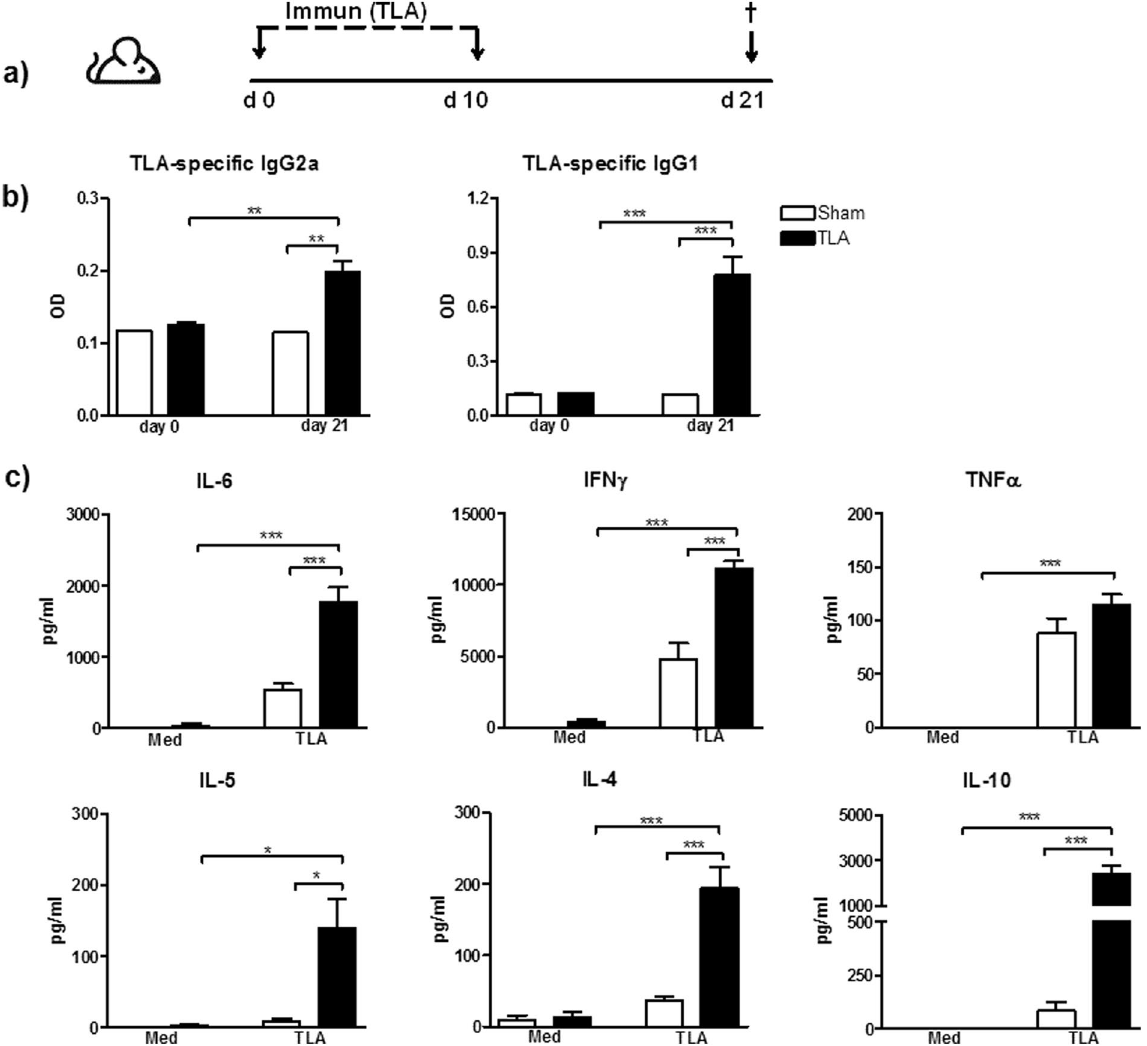
Figure 2. Antibody production and recall responses in mice immunized with TLA. Mice were immunized intraperitoneally with 10 µ g TLA in alum on days 0 and 10 (TLA group). Controls received PBS in alum (Sham group) ( a ). Levels of TLA-specific serum antibodies collected on day 0 and day 21 were determined by ELISA ( b ). Spleens were collected at day 21 and single cell suspensions (5 × 10 6 cells/ml) were cultured in the presence of medium only (Med) or 5 µ g/ml TLA for 72 h. Levels of cytokines in culture supernatants were determined by ELISA ( c ). Data are representative of three experiments (n = 5 mice per group). Results of Student´s t test: * P < 0.05, ** P < 0.01, *** P <